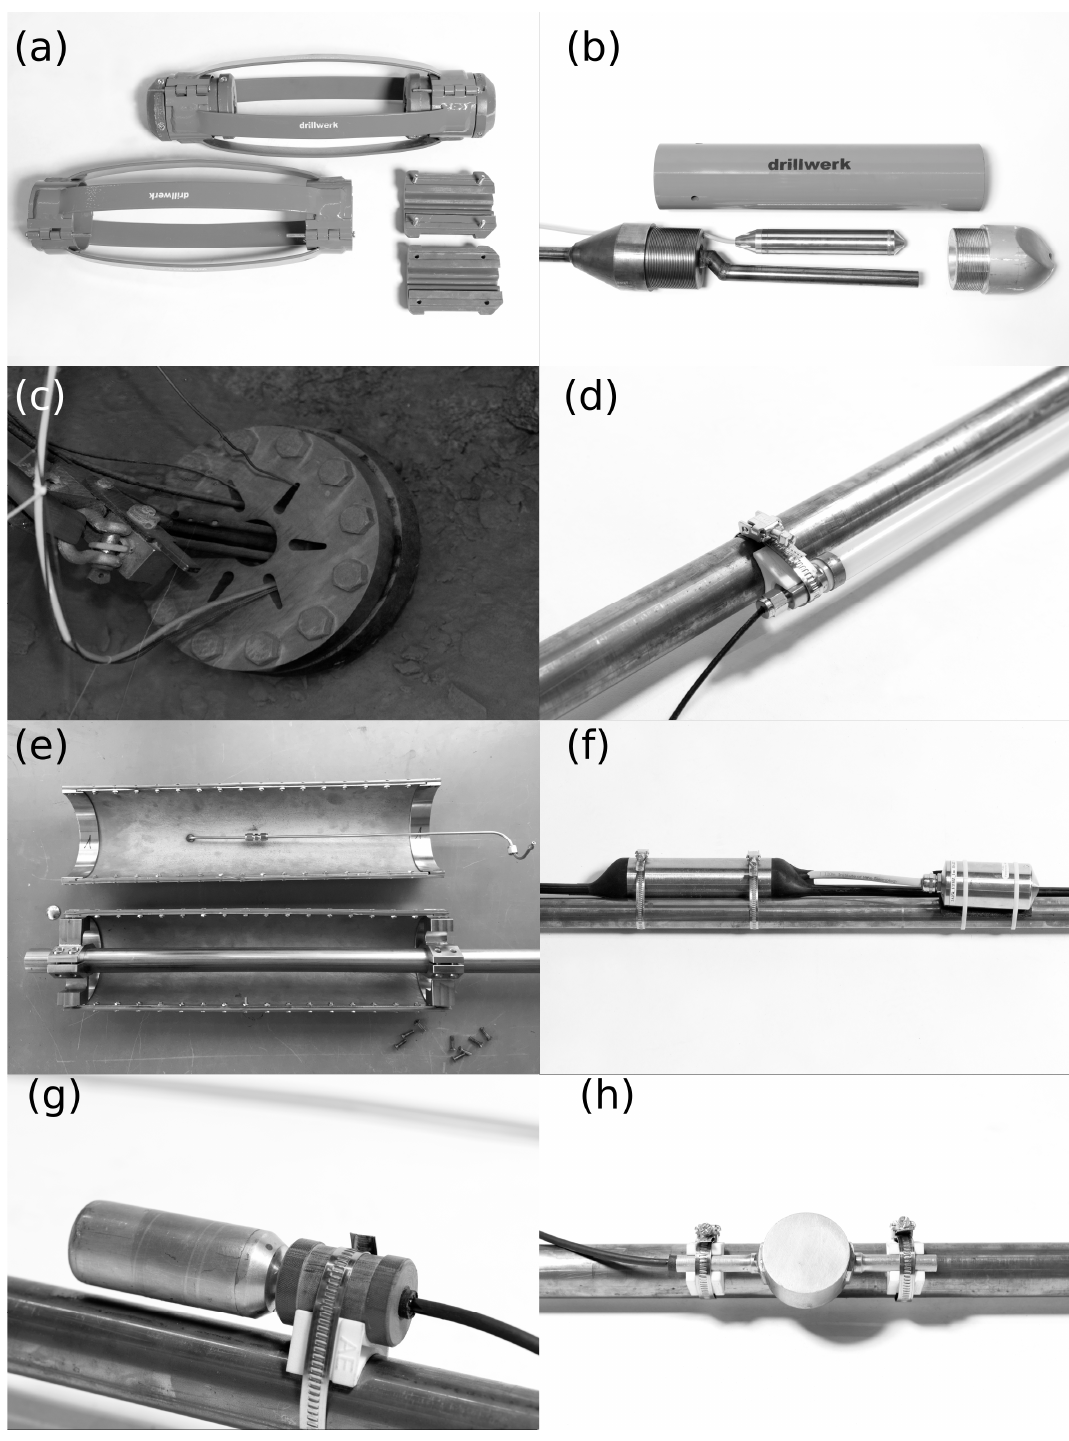
Figure 6. Main components of the BRP multi-sensor monitoring network installed together in the same monitoring boreholes: ( a ) centralizer with integrated cable clamp; ( b ) frontshoe with integrated geophone; ( c ) top plug; ( d ) fiber Bragg grating (FBG) sensor; ( e ) cementable tube pore pressure (CTPP) sensor; ( f ) high-frequency accelerometer with pre-amplifier; ( g ) in situ acoustic emission (AE) sensor; and ( h ) ultrasonic transmitter. For details, see Section 3.4 Installation and Guidance System for ( a – c ); Section 3.5 Geomechanics for ( d , e ); Section 3.6 Seismology for ( b , f , g ); and Section 3.7 Active Seismics for ( h ). An overview of size, numbers, and locations is given in Table 1.